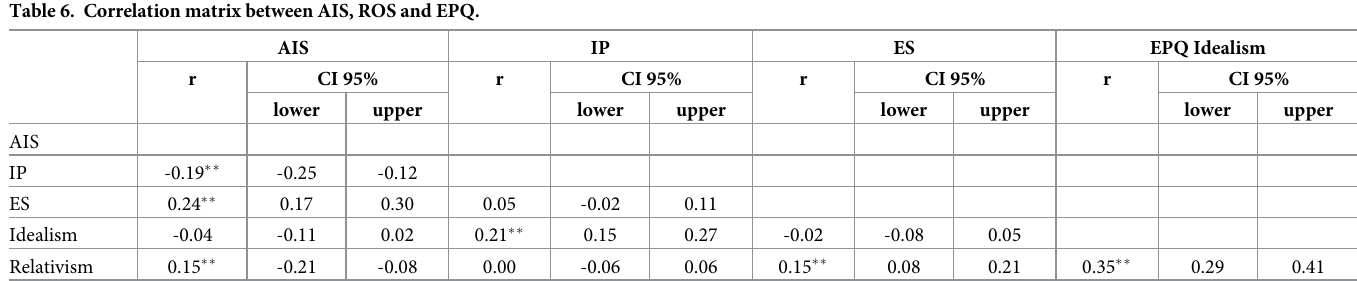
Table 6. Correlation matrix between AIS, ROS and